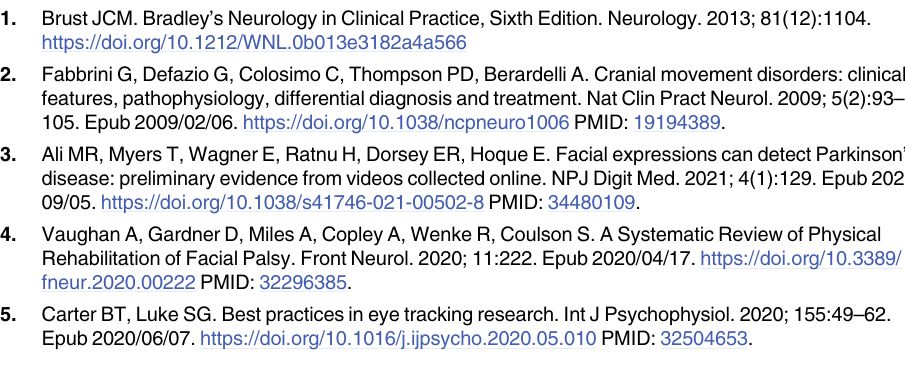
S1 Fig. Mock-PerfO Activity-Level CNN Classifier Architecture. Architecture diagram of the final CNN implemented for activity classification. A single channel spectrogram computed from the segmented waveform is input to the model at classification time. A probability distri- bution over each of the 16 activities is output. The activity associated with the highest output likelihood estimate is